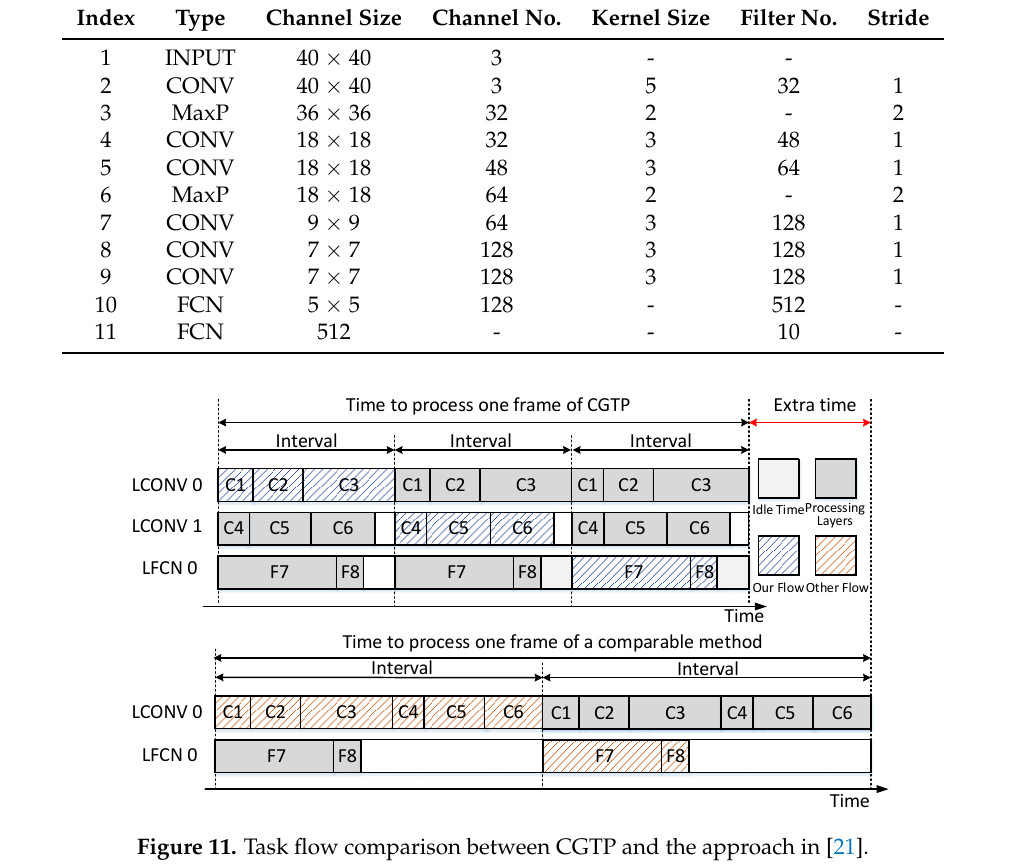
Table 1. D-Net model architecture.